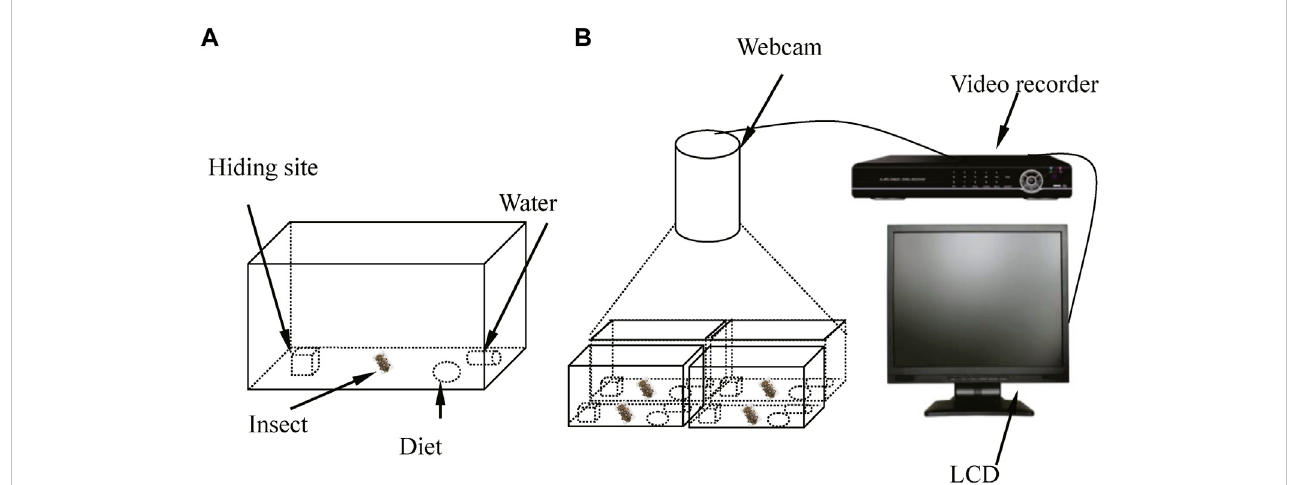
Figure 1 Schematic of the behavioral bioassay chamber used to monitor the circadian rhythms of locomotor activity by female adults under different conditions. (A) Females D. helophoroides were placed in the breeding box during the experiment. (B) The equipment used to observe the locomotor activity of female adults during the experiment. LCD: liquid crystal